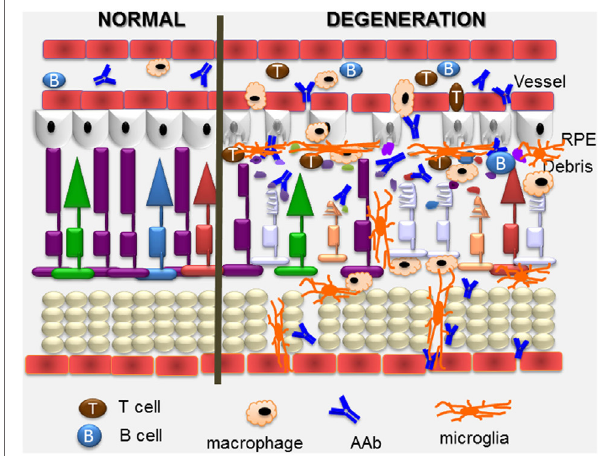
FigURe 4 | Overview of pathogenic autoimmune processes on the retina. Anti-retinal autoantibodies (AAbs) can provoke and can be a consequence of retinal degeneration. AAbs attract activated microglia/microphages that produce pro-inflammatory cytokines and chemokines, and induce apoptosis of cone and rod photoreceptor cells (showing on the right), resulting in retinal degeneration. Inflammatory cytokines and chemokines, activation of microglia and photoreceptor apoptosis can trigger secondary autoimmunity, and production of new anti-retinal AAbs. Cytotoxic T cells specific for retinal antigens are likely also involved in the pathogenic